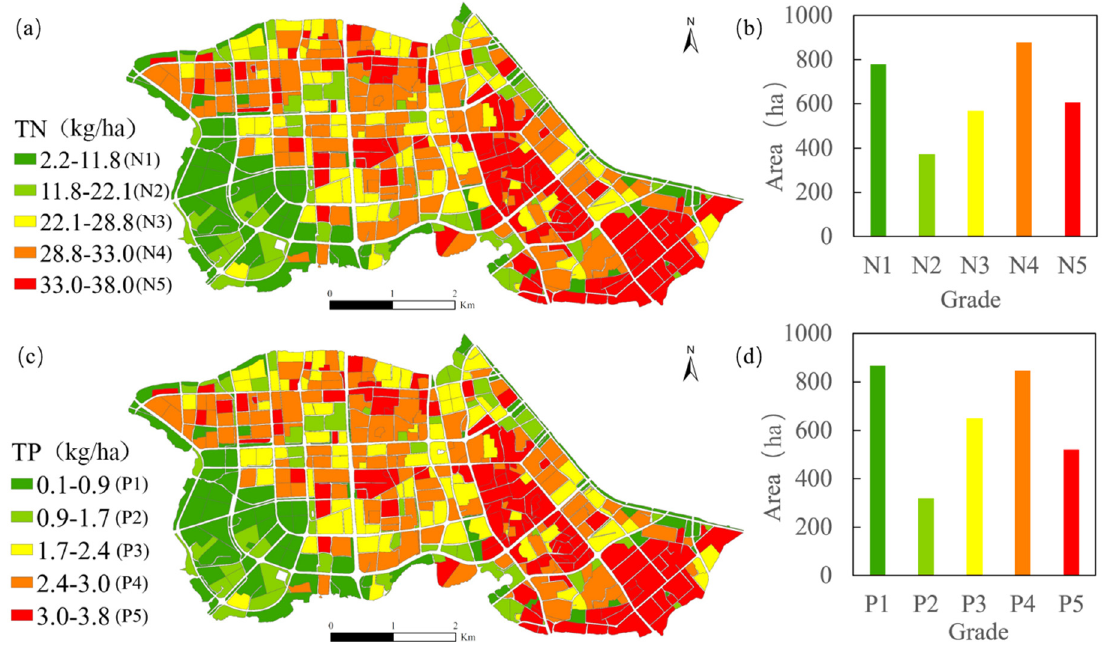
Figure 5. Spatial distribution of total nitrogen (TN) flux ( a ) and total phosphorus (TP) flux ( c ) in the study area and its area, ( b , d ) is the total areas corresponding to different TN and TP flux range values.